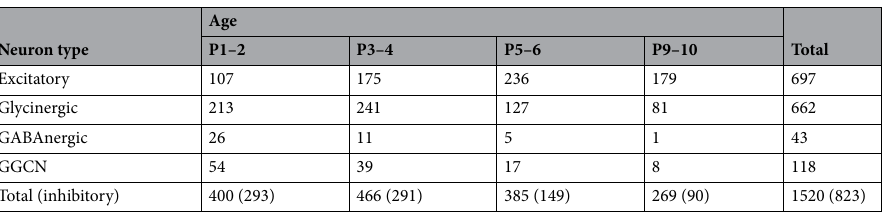
Table 1. Total number of inspiratory neurons. Data are shown as the total number of each type of inspiratory neurons from five rhythmic slices at each age group. The numbers in parentheses at the lowest row indicate the total number of inhibitory inspiratory neurons at each age. Both in the total inspiratory neuron group and total inhibitory inspiratory neuron group, the composition of inspiratory neurons were significantly different among respective age groups ( P < 0.05; Pearson’s Chi-square